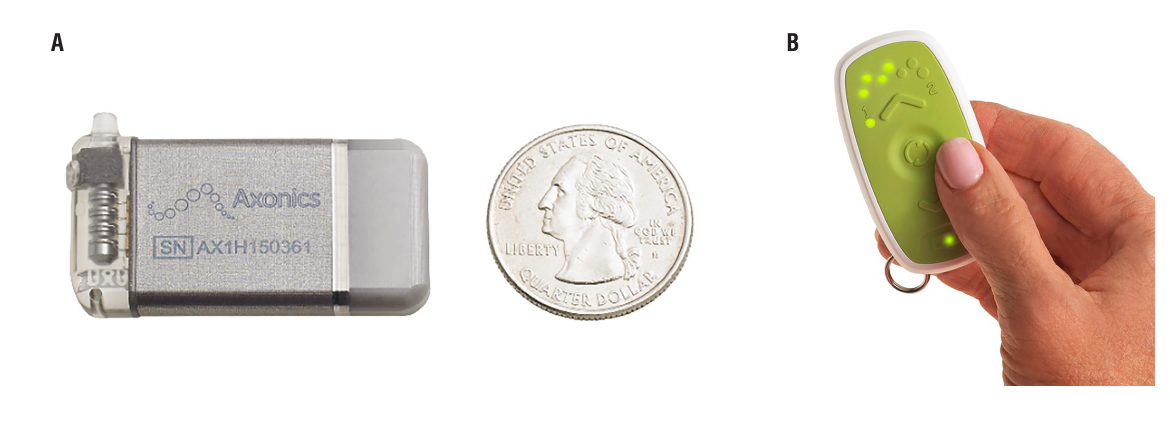
Figure 2 - Axonics r-SNM™ implantable pulse generator (A) and patient therapy controller